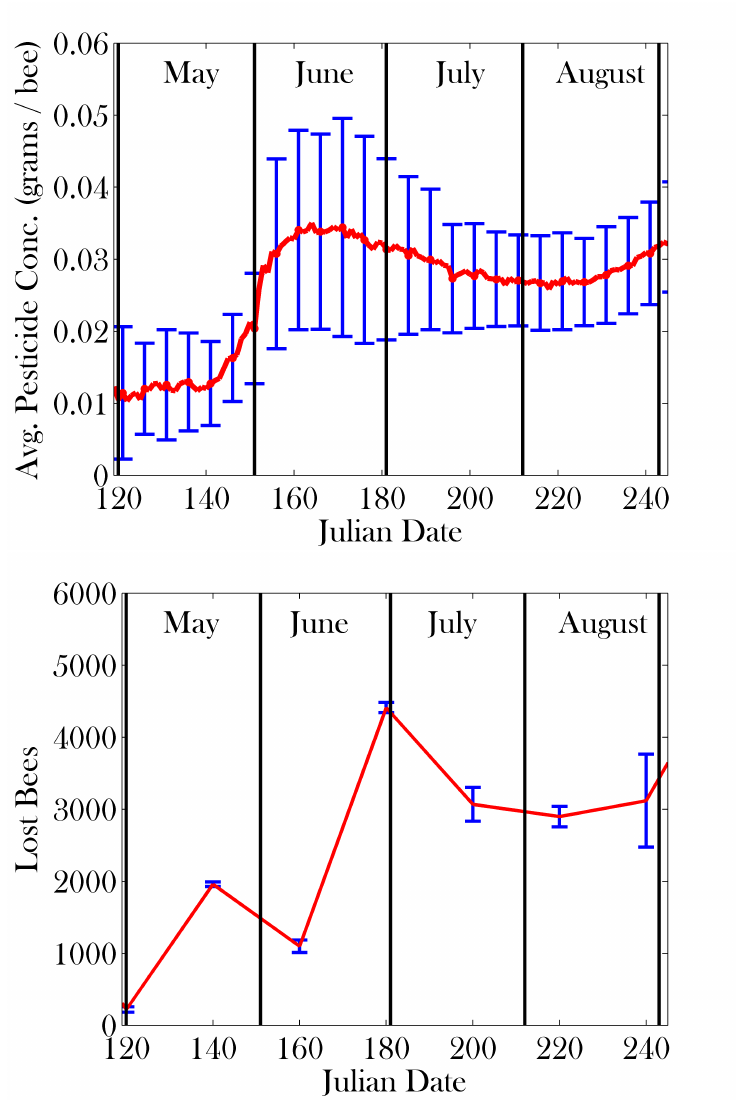
Figure 11. Toxicity of foragers and its effect on navigation over time. Seven simulations were used. Error bars represent one standard deviation. The top plot shows the metabolic efforts of the bees are not enough to completely flush the pesticides from their system. We see that once pesticide concentration in a bee is high enough to force higher metabolic effort, there is a decrease to a more stable concentration. The bottom plot shows the correlation between pesticide exposure and its effects on navigation. Plotted is the current date versus the number of bees lost in the previous 20 days. Bees are considered lost if they die outside a radius of nine patches from the hive (food is at most nine patches away). This plot highlights the functionality of Bee++ as well as how pesticide exposure may explain one possible symptom of